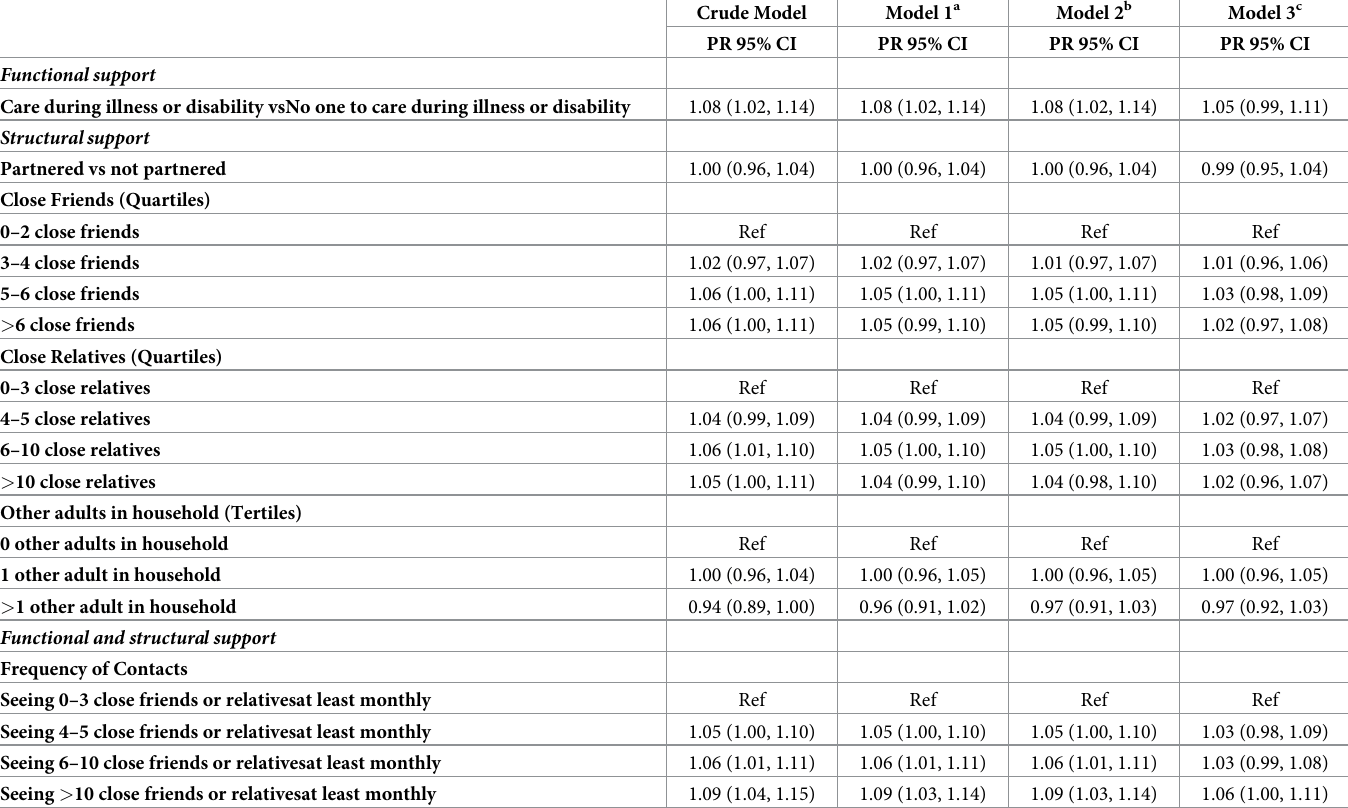
Table 3. Adjusted models with prevalence ratios and 95% confidence intervals of high medication adherence by social support